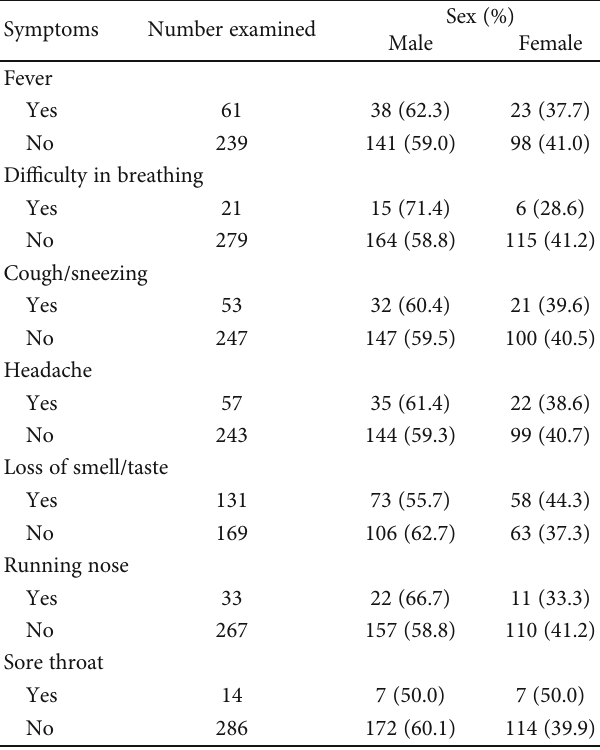
Table 1: Prevalence of malaria and COVID-19 coinfection in relation to sex.